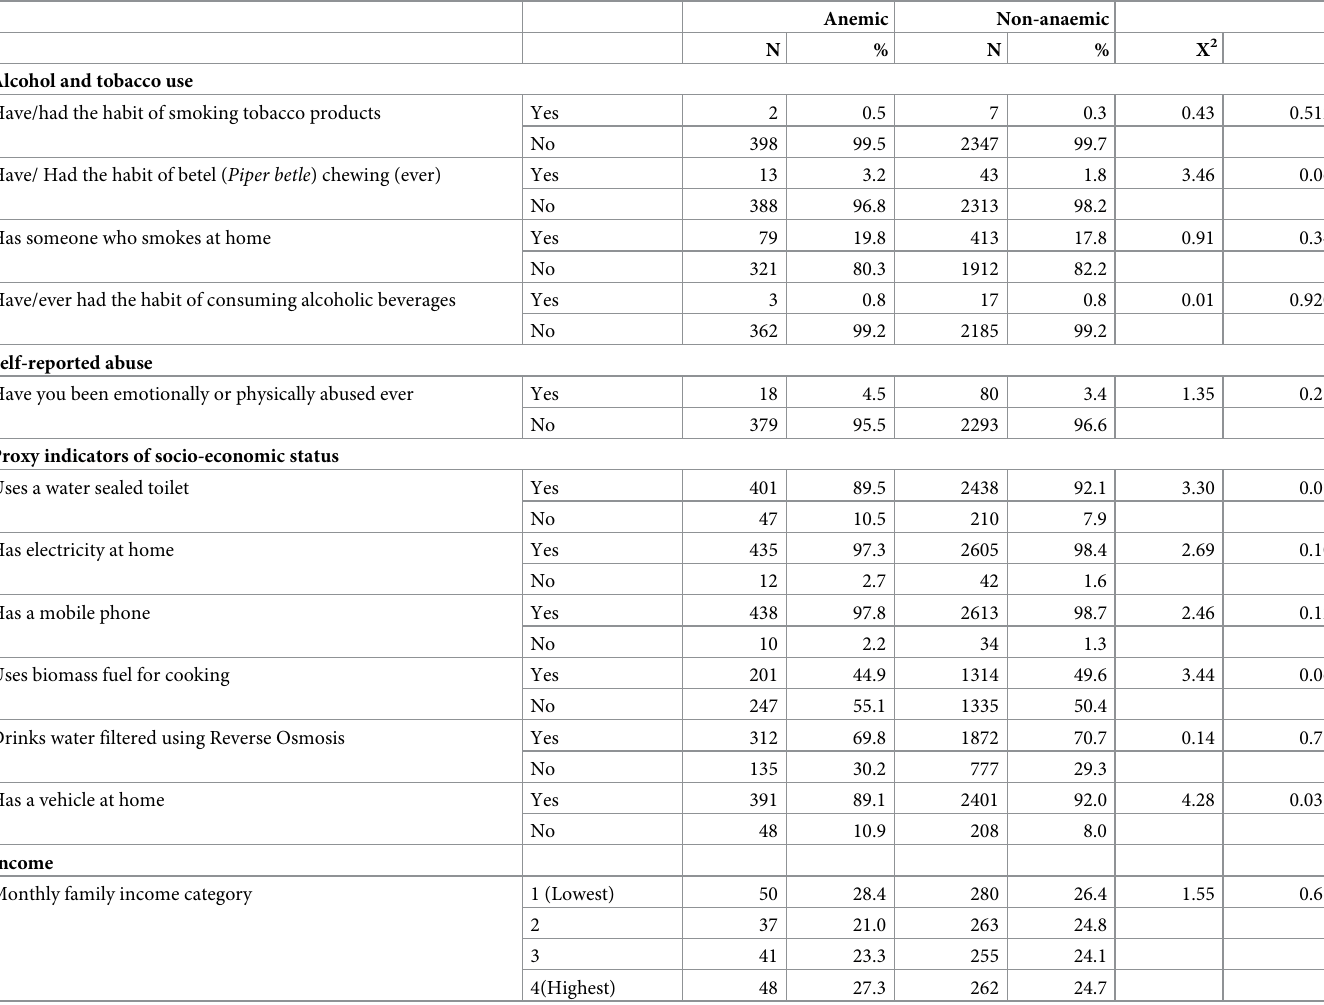
Table 2. Social and economic conditions associated with anemia among first-trimester pregnant women in the Anuradhapura district.